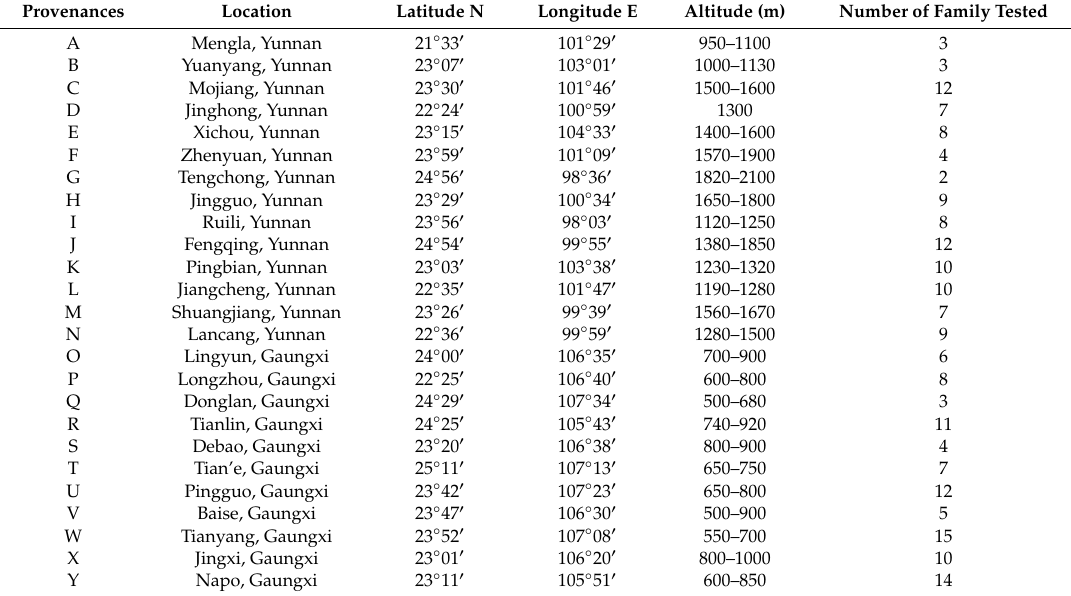
Table A1. Location of 25 provenances of Betula alnoids investigated in the